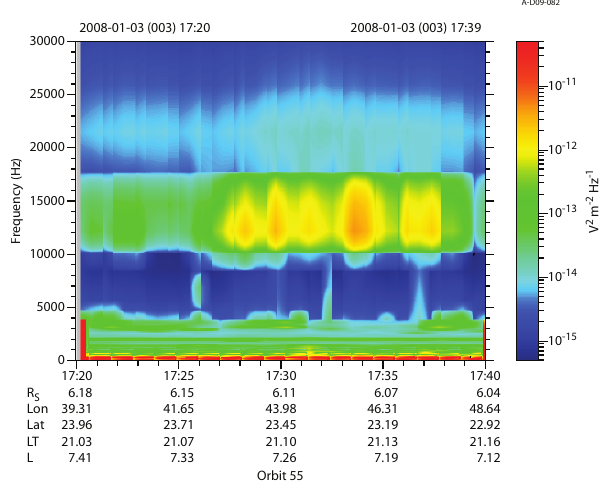
Fig. 2. A wave spectrogram showing a close up of the region near a probable source region of NB emission.